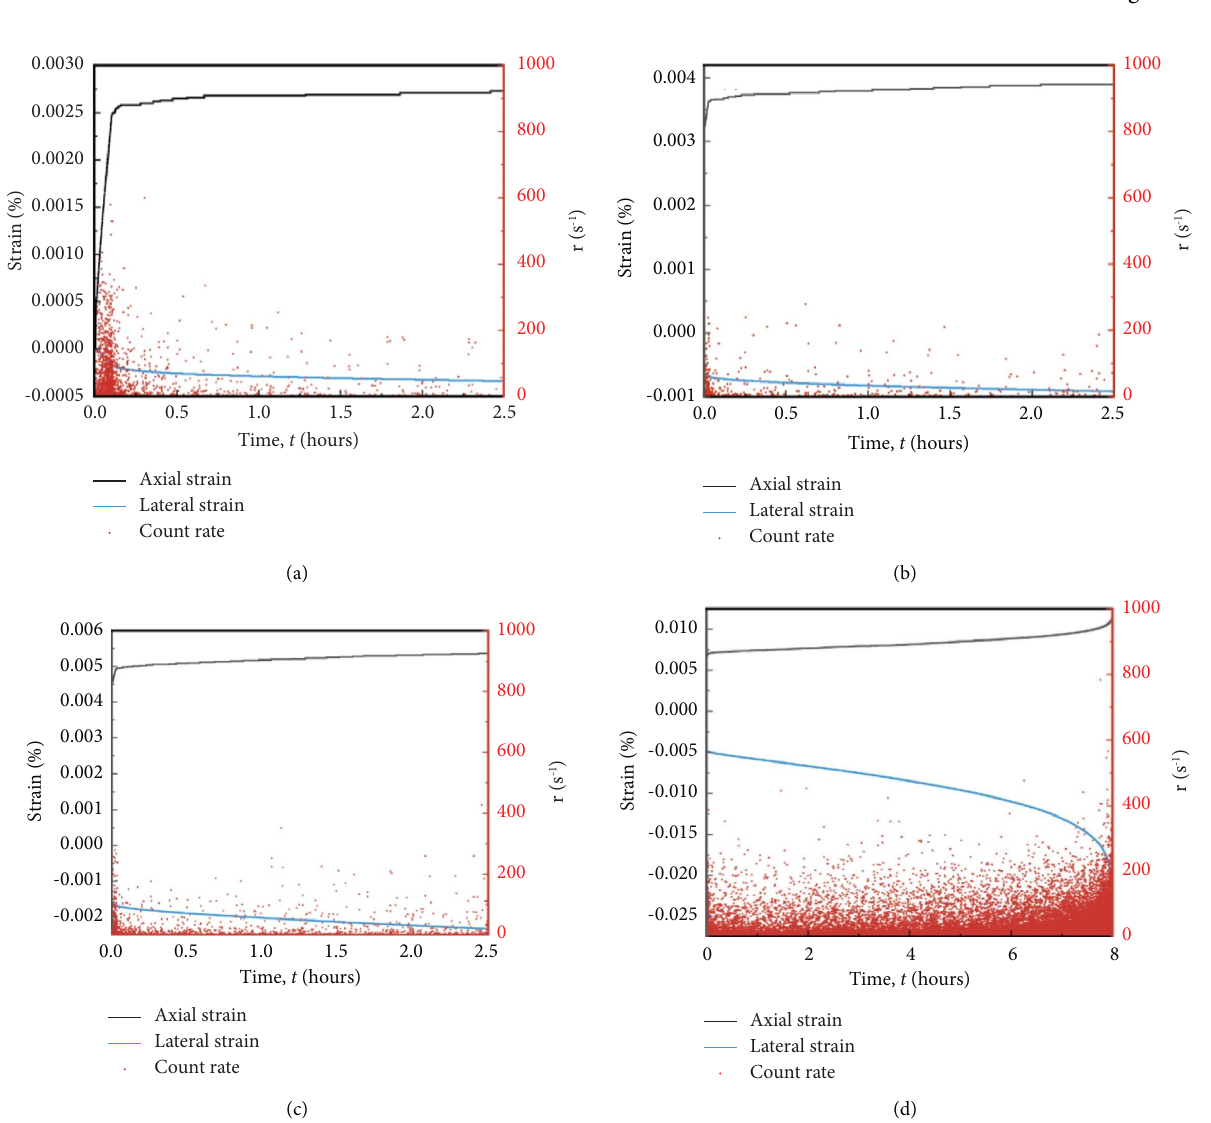
. (b) 0.5 σ . ucs ucs